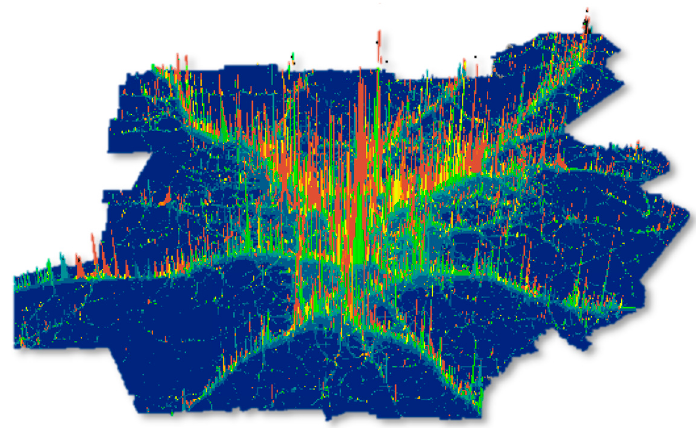
Figure 2. 3D geovisualization of tra ffi c-related particulate matter (PM 2.5 ) concentrations (R-LINE model output).